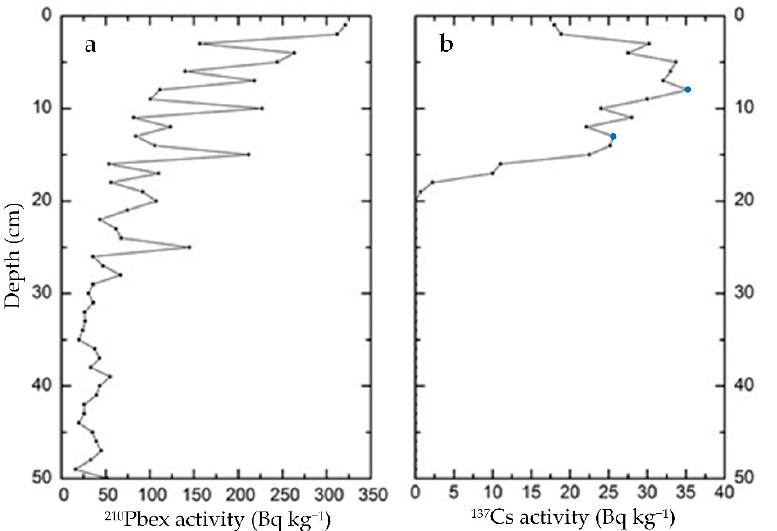
Figure 2. Unsupported 210 Pb ( a ) and 137 Cs ( b ) activities in the peat profile. The blue circles indicate two representative radioactive incidents: the peaks indicating nuclear tests at 13 cm in 1963 and the Chernobyl incident at 8 cm in 1986.